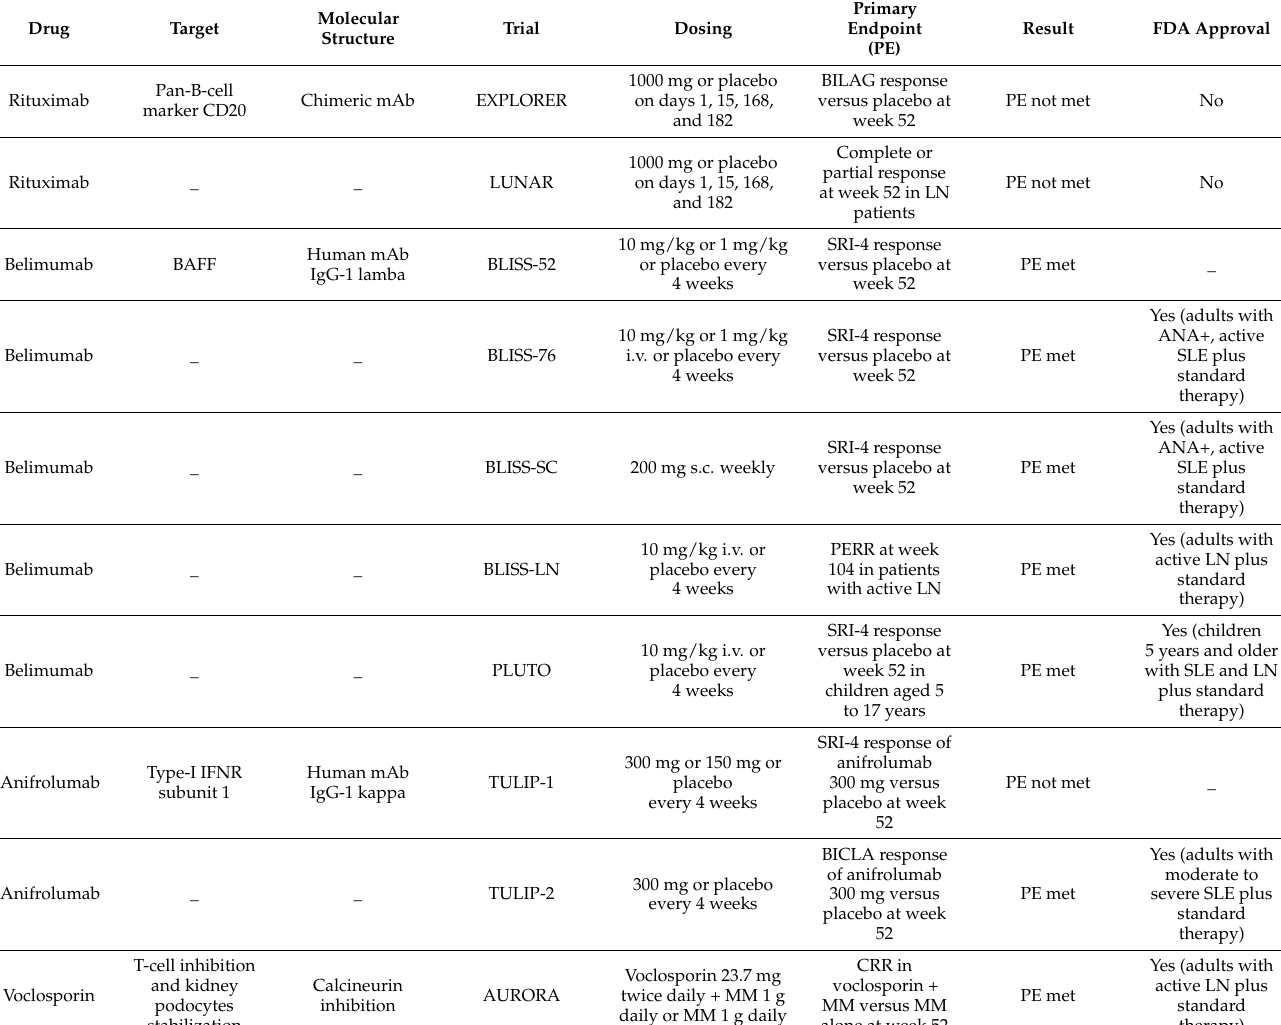
Table 1. Major clinical trials of new drugs currently used for SLE